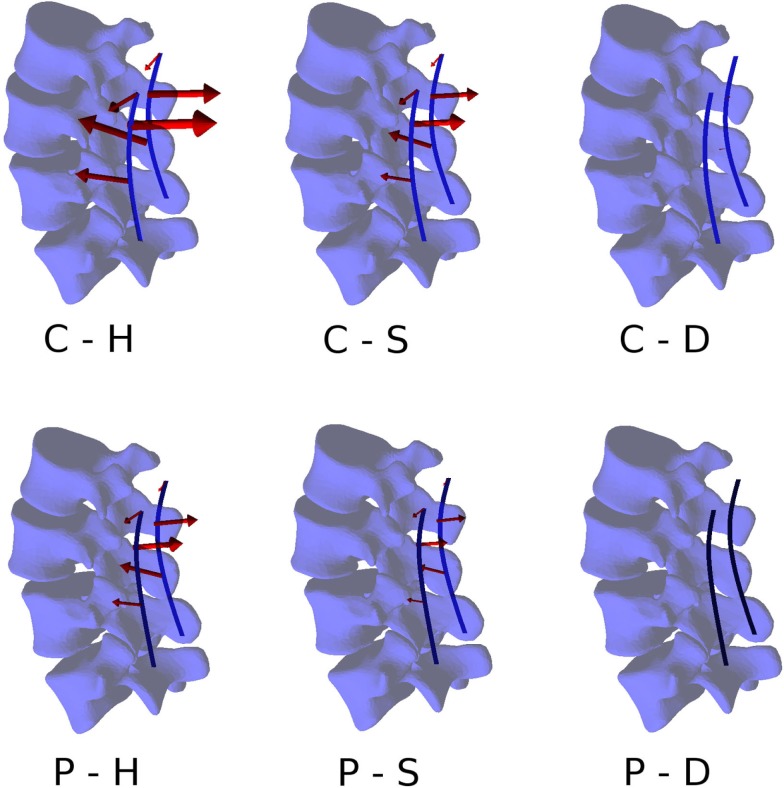
Forces acting at the pedicle screw–bone interfaces, represented by the red arrows (sizes proportional to the magnitude of the forces), calculated for the six configurations. Pull-out forces are predicted at L2 (arrows directed outwards), whereas push-in forces at L3 (arrows directed inward).